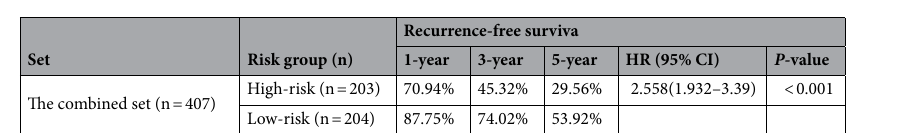
Table 5. Comparison of RFS in patients with NSCLC based on the fifteen-mRNA signature in the combined training set and the validation set (n = 407, GSE30219 and GSE50081). The results show that the RFS of the high-risk group was significantly shorter than that of the low-risk group ( P < 0.001).